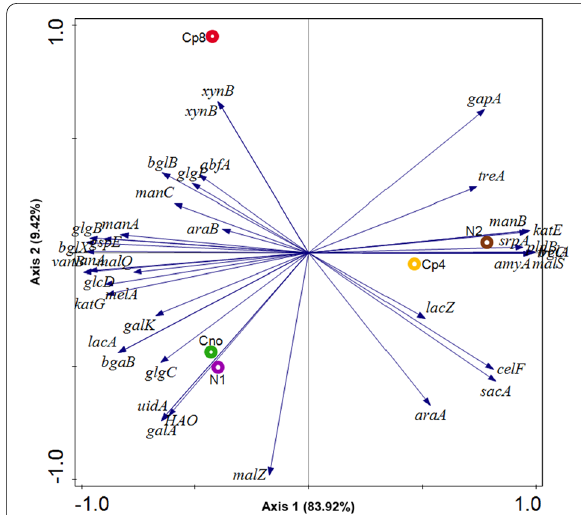
Fig. 7 PCA (Principal component analysis) of carbon cycling genes obtained under organic, inorganic and unfertilized rhizosphere soil samples from maize